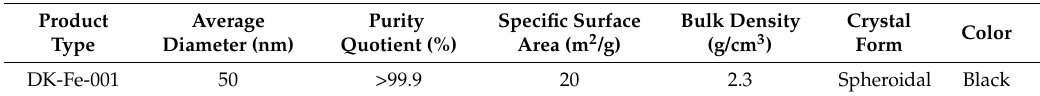
Table 1. Characteristics of Nanoscale zero-valent iron powder.